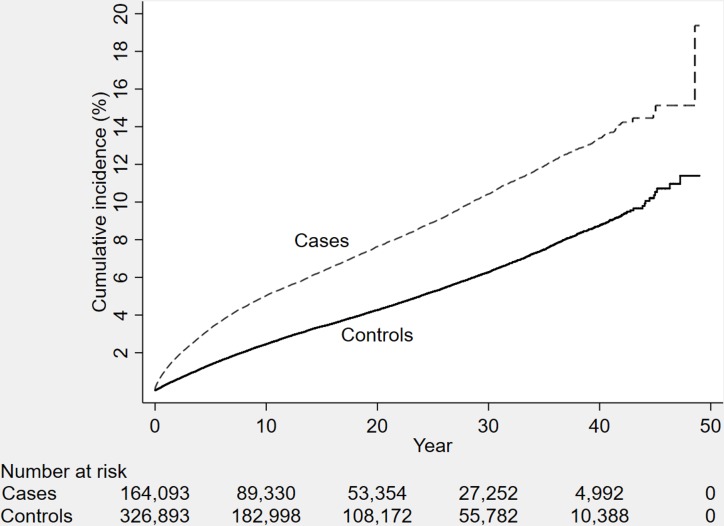
The cumulative incidence of dementia diagnosis during follow-up in individuals with and without TBI at baseline (n = 491,252 individuals).TBI, traumatic brain injury.